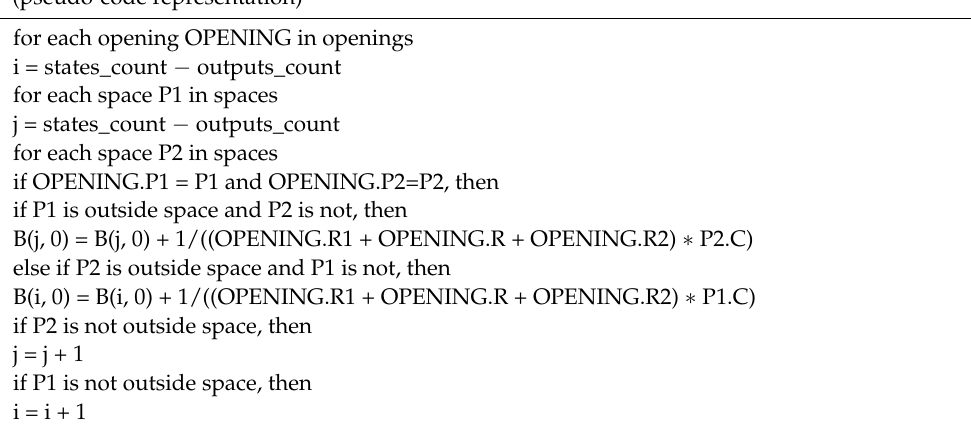
Algorithm 5. The modification of the input matrix B —openings and spaces (pseudo-code representation)